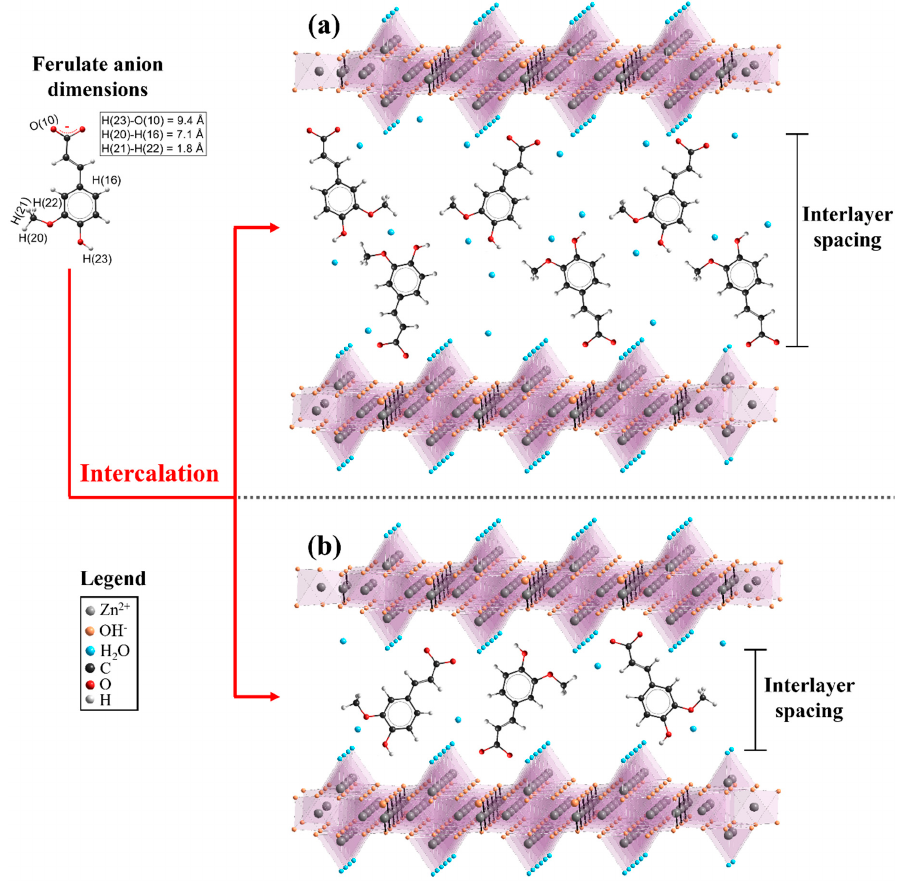
Figure 6. Schematic representations of proposed ( a ) bilayer and ( b ) monolayer arrangements for the ferulate anions in the LSH-ferulate materials. Molecules 2021 , 26 , x The CIELab color diagram (Figure 7) shows that LSH-ferulate materials have a yel- lowish-white color; consequently, their use in sunscreen formulations do not compromise the desired aesthetics appearance for the cosmetic products. In the UV-VIS diffuse reflec- tance spectra (Figures A2 and A3), it is observed that LSH-ferulate materials have absorp- tion edge situated in the 350–400 nm region similar to Nafel salt. Moreover, each layered material has a characteristic visible-light scattering (400–800 nm) due its particle size and refractive index associated to constituent LSH structures.